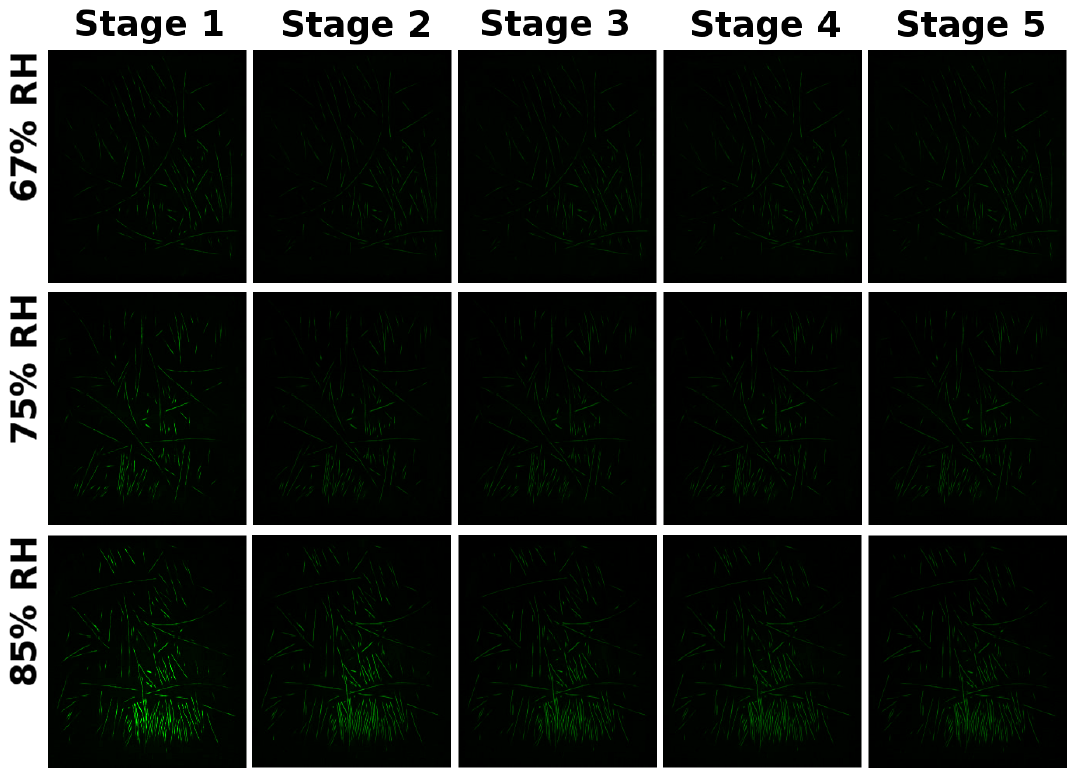
Figure 8. Video snapshots from water desorption in hair samples. The first row shows five frames from hair capacitive images over time after acclimatization in 67%RH. Rows two and three show the same sample after acclimatization in 75% and 85%RH chambers correspondingly. The contrast is modified to highlight hair samples.